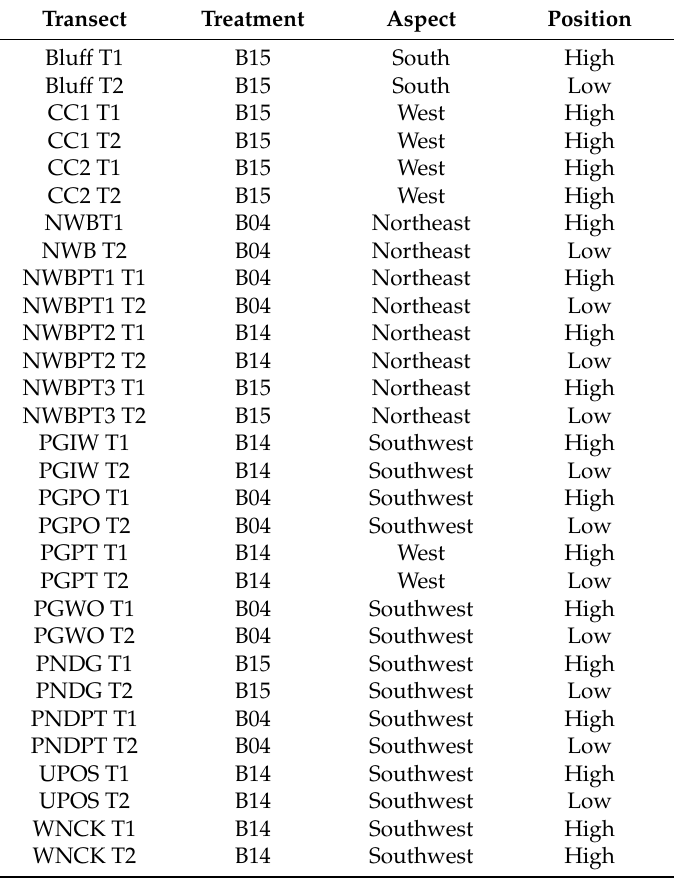
Table 1. Transects located at the Alice L. Kibbe Field Station, Hancock Co., IL, in west-central Illinois showing treatment, aspect, and transect position. Transects considered “High” were up slope, whereas those considered “Low” were